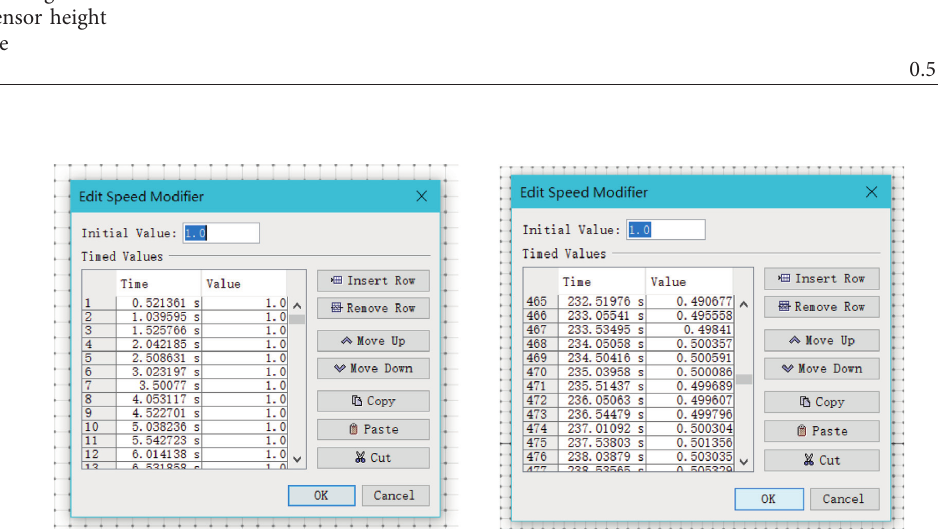
Figure 7: Speed modifier.